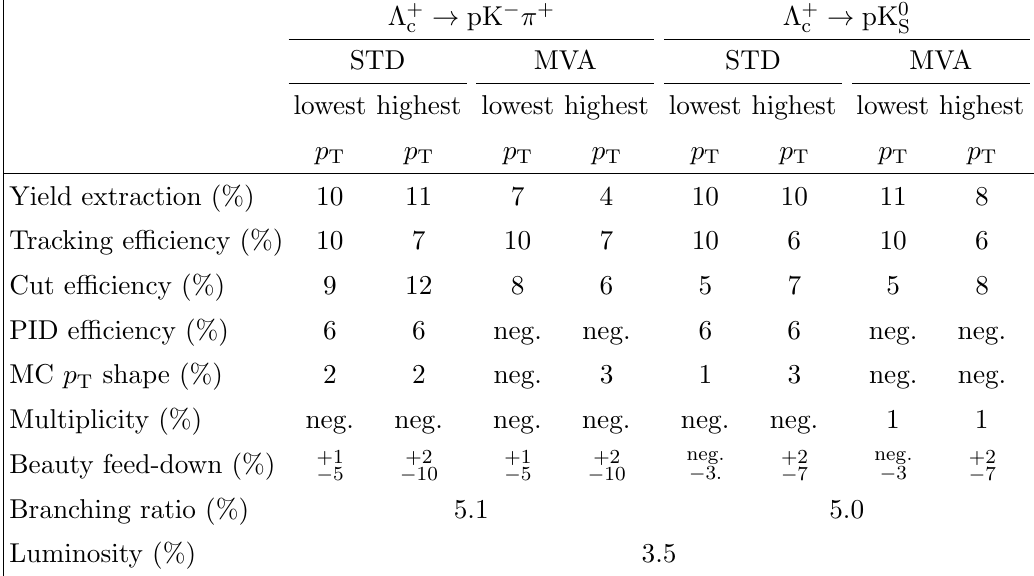
Table 3 . Summary of relative systematic uncertainties for the lowest and highest p T intervals considered in the analysis for the two (cid:3) c hadronic decay modes and the two analysis techniques in p-Pb collisions. When the uncertainty was found to be < 1%, it was considered negligible (\neg." in the